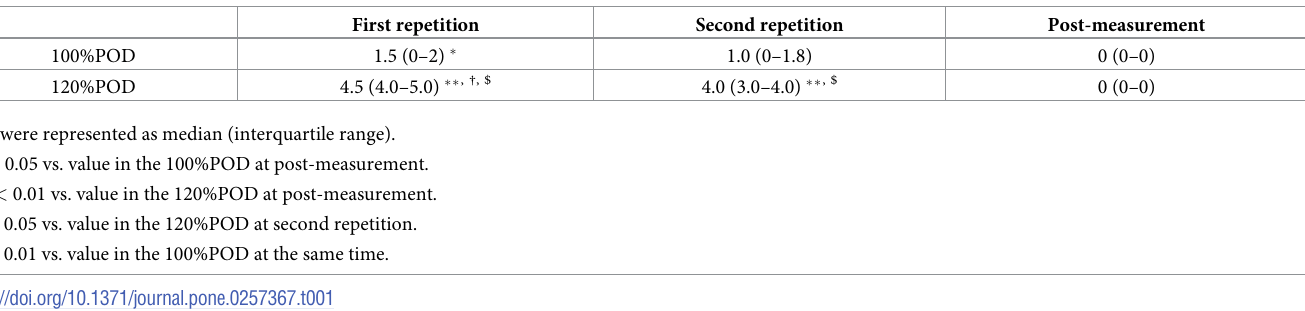
Table 1. Pain of the